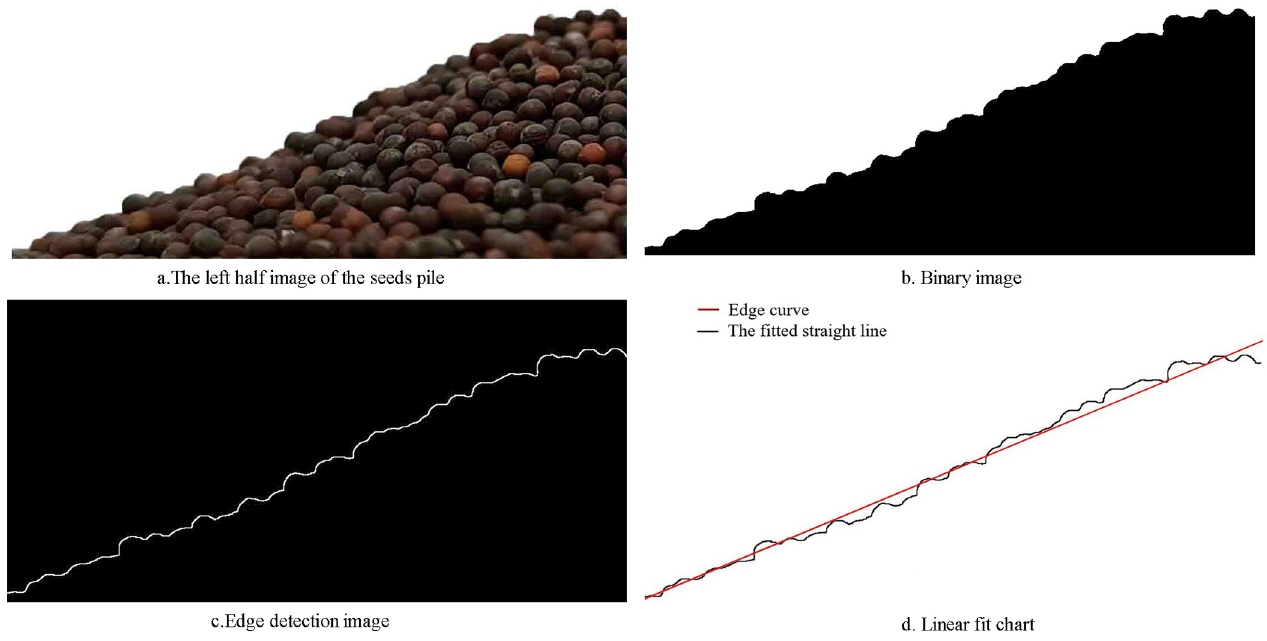
Fig 4. Image processing of Chinese cabbage seeds’